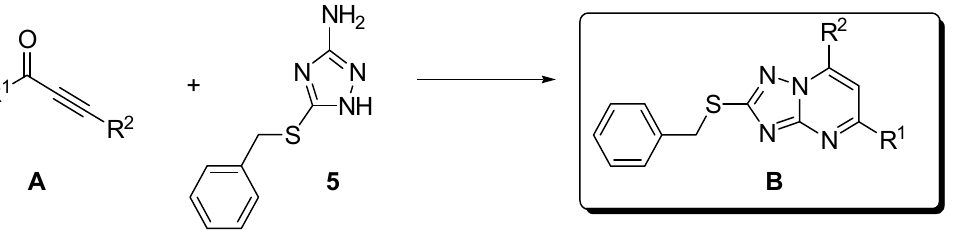
Scheme 1. Cyclocondensation of α‐ acetylenic ketones A with 3 ‐ amino ‐ 5 ‐ benzylsulfanyl ‐ 1,2,4 ‐ triazole.